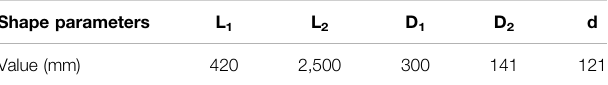
TABLE 2 | Geometry parameters of the bend stiffener.